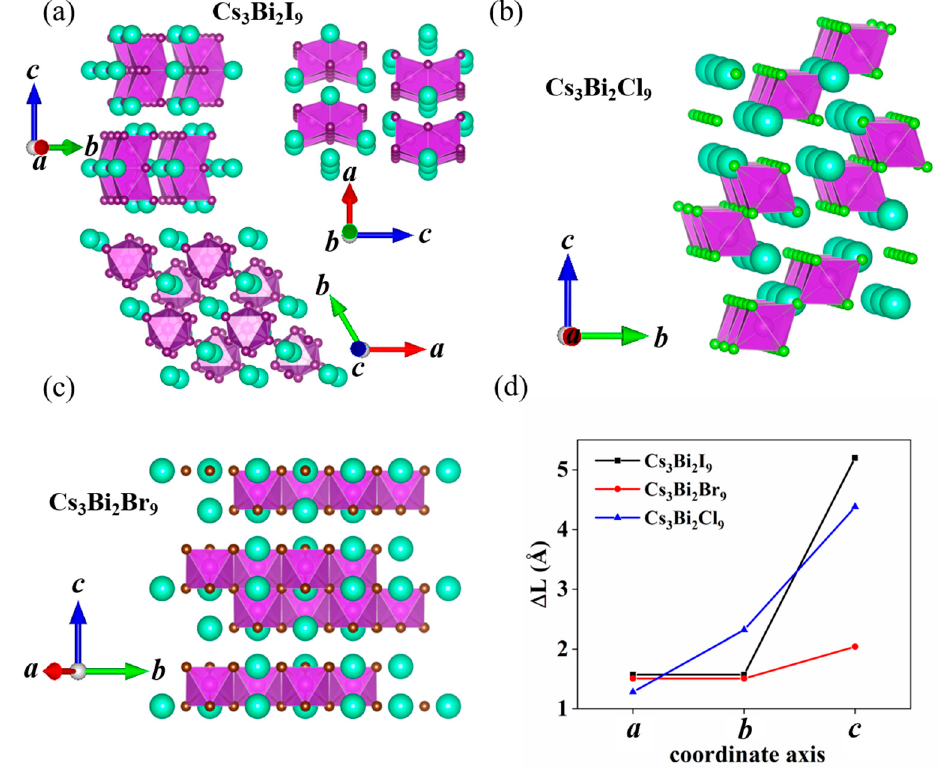
Figure 7. Crystal structure of the zero-dimensional Cs 3 Bi 2 I 9 ( a ), one-dimensional Cs 3 Bi 2 Cl 9 ( b ), and two-dimensional Cs 3 Bi 2 Br 9 ( c ). Difference in the lattice constants of the Cs 3 Bi 2 X 9 perovskites for the pressures between 0 and 40 GPa along the a, b, and c axes ( d ). The black, red, and blue lines represent Cs 3 Bi 2 I 9 , Cs 3 Bi 2 Br 9 , and Cs 3 Bi 2 Cl 9 , respectively.